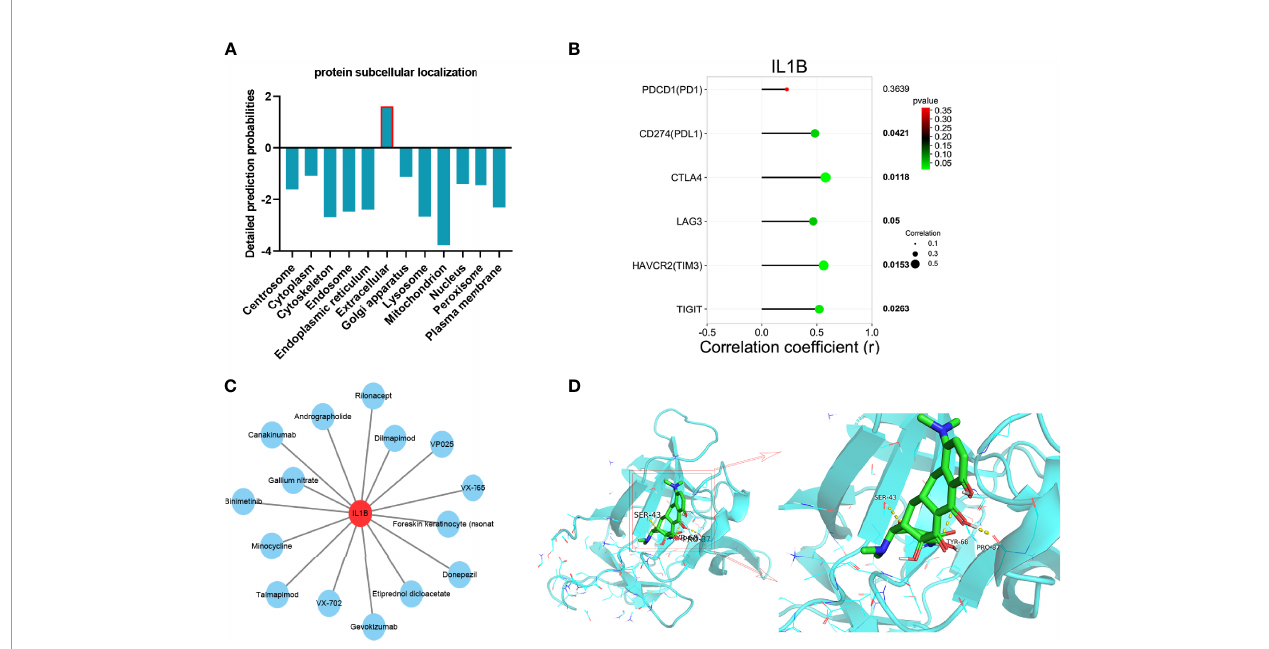
FIGURE 10 | Integrated analyses of IL1B. (A) protein subcellular localization of IL1B. (B) The correlation between immune checkpoints and IL1B. (C) Drug – gene interaction network of IL1B. (D) Molecular docking between IL1B and